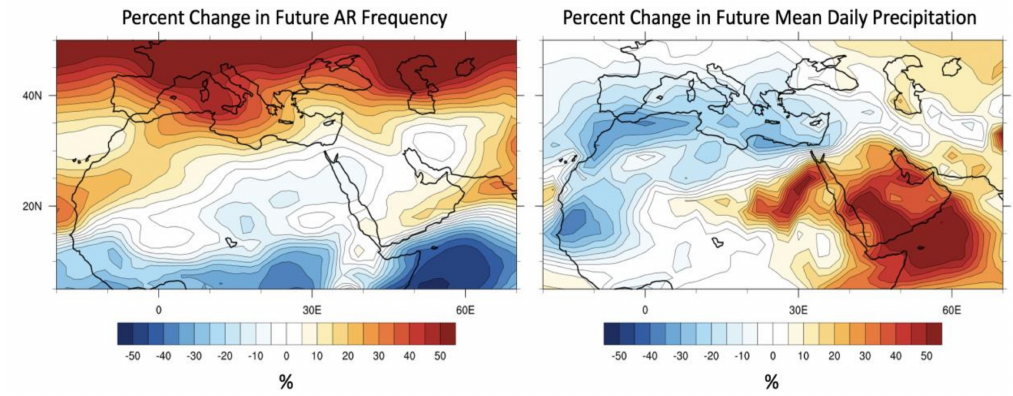
Figure 9. ( Left ) Relative values for the projected change in future AR frequency, calculated as the percent change in projected future values compared to historic climatology (%) for the MENA region. ( Right ) Relative values for the projected change in future mean daily precipitation (%) for the MENA region. The CMIP5 historical simulations range from 1979–2002 and the future (RCP8.5) scenario simulations range from